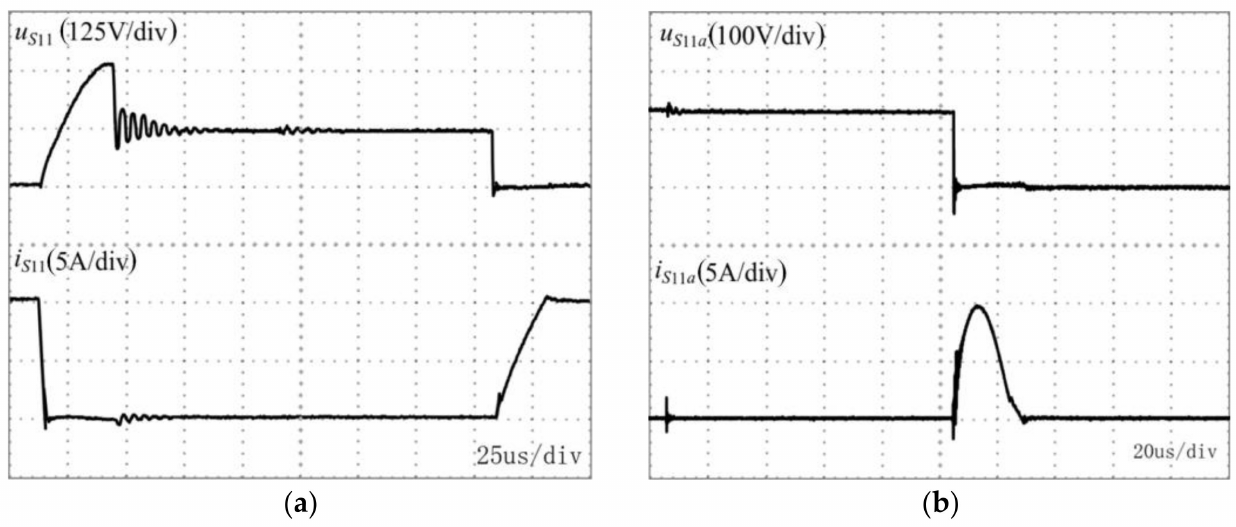
Figure 9. Waveforms of ( a ) switch S11, and ( b ) switch S11a; C 11 = C 12 = C 13 = C 14 = 1.0 µ F; L 11 = L 14 = 120 µ H, L 12 = L 13 = 300 µ H, switching and output frequency of 500 Hz and 50 Hz, respectively, and modulation depth factor of